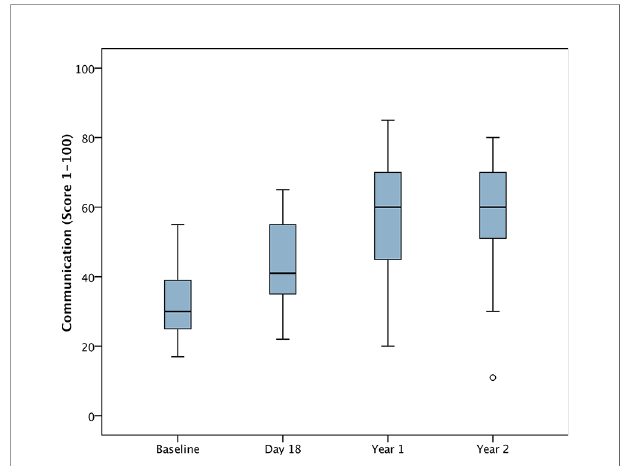
FIGURE 2 | Box plot: DD-C-GAS Communication (N = 25). Non-parametric repeated measures ANOVA (Friedman test): p = 0.000***. Pairwise comparisons between time points (Wilcoxon signed rank test): p-values adjusted by Bonferroni-Holm were 0.000***, except for comparisons Day 18 to Year 1 (p = 0.002**), and Year 1 to Year 2 (p = 0.460).